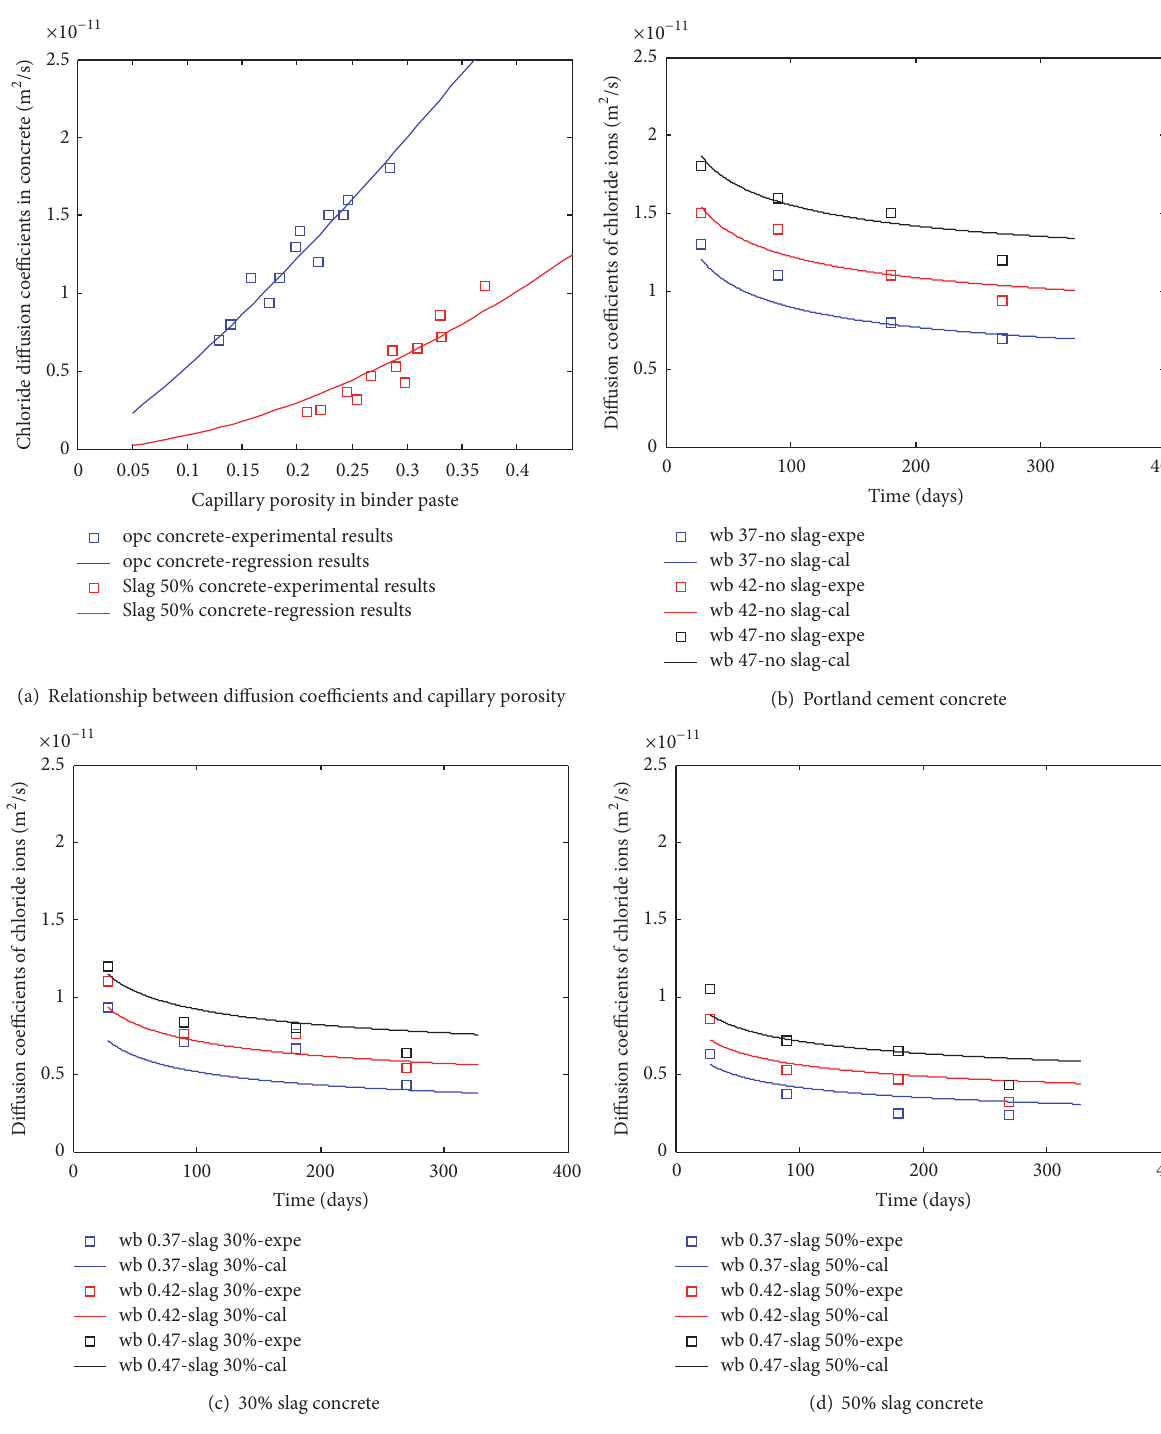
Figure 6: Chloride diffusion